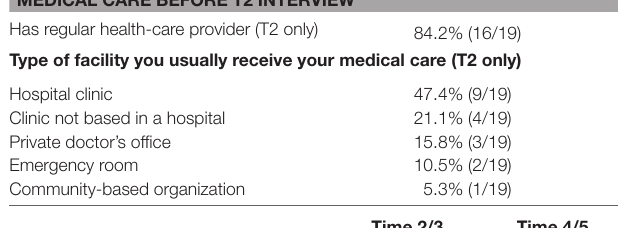
TaBle 2 | Patterns of linkage to hiV care and clinical outcomes. MeDical care BeFOre T2